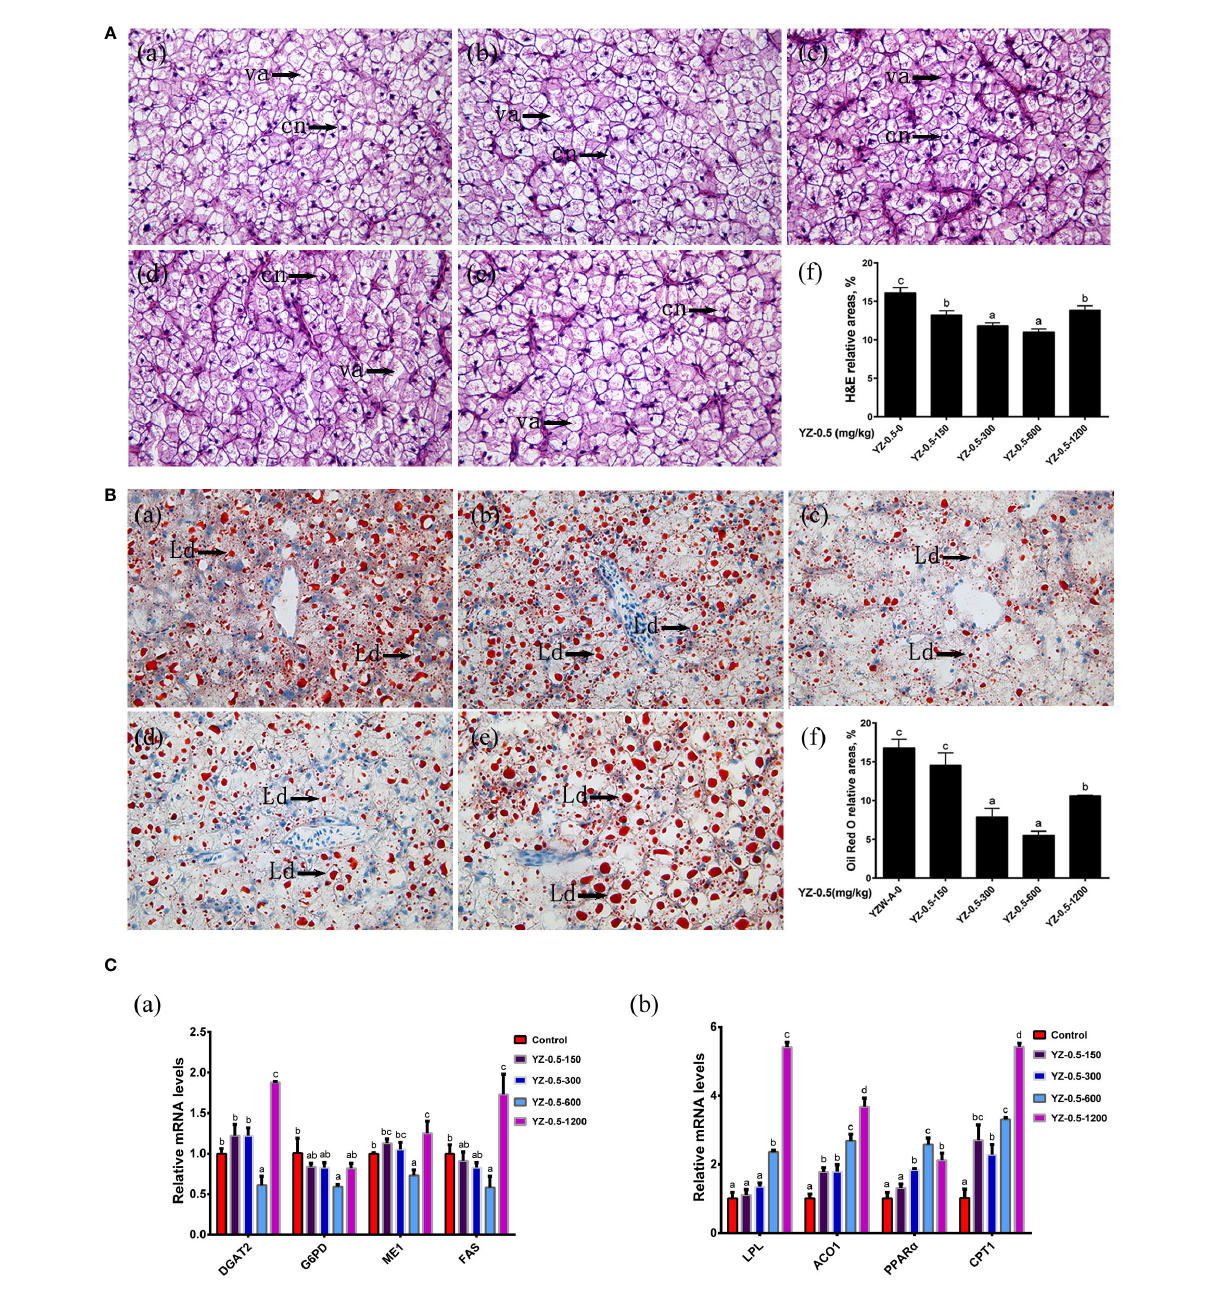
FIGURE 3 Effect of YZ0.5-A on the liver in vivo . (A) Histology (100×, cn: cell nucleus, va:vacuolation). (a) Liver from fi sh fed 0 mg/kg YZ-0.5A (YZ-0.5-0); (b) Liver from fi sh fed 150 mg/kg YZ-0.5A (YZ-0.5-150); (c) Liver from fi sh fed 300 mg/kg YZ-0.5A (YZ-0.5-300); (d) Liver from fi sh fed 600 mg/kg YZ- 0.5A (YZ-0.5-600); (e) Liver from fi sh fed 1200 mg/kg YZ-0.5A (YZ-0.5-1200); (f) Relative areas for hepatic vacuoles in H&E staining. (B) Histochemistry (Oil Red O staining, 400 ×, Ld: lipid droplet). (a) Liver from fi sh fed 0 mg/kg YZ-0.5A (YZ-0.5-0); (b) Liver from fi sh fed 150 mg/kg YZ-0.5A (YZ-0.5-150); (c) Liver from fi sh fed 300 mg/kg YZ-0.5A (YZ-0.5-300); (d) Liver from fi sh fed 600 mg/kg YZ-0.5A (YZ-0.5-600); (e) Liver from fi sh fed 1200 mg/kg YZ-0.5A (YZ-0.5-1200); (f) Relative areas for lipid droplets in Oil Red O staining. Lipids appear red, and nuclei appear blue after staining with Oil Red O. (C) Gene expression in vivo . Means in the same row with different superscripts are signi fi cantly different ( P <